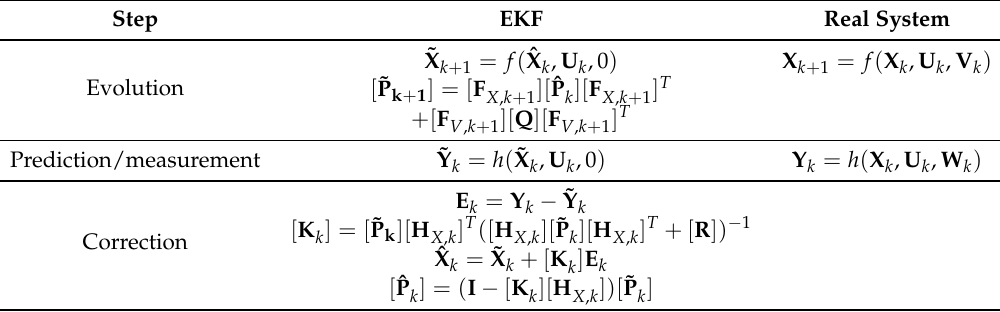
Table 2. EKF estimation steps.